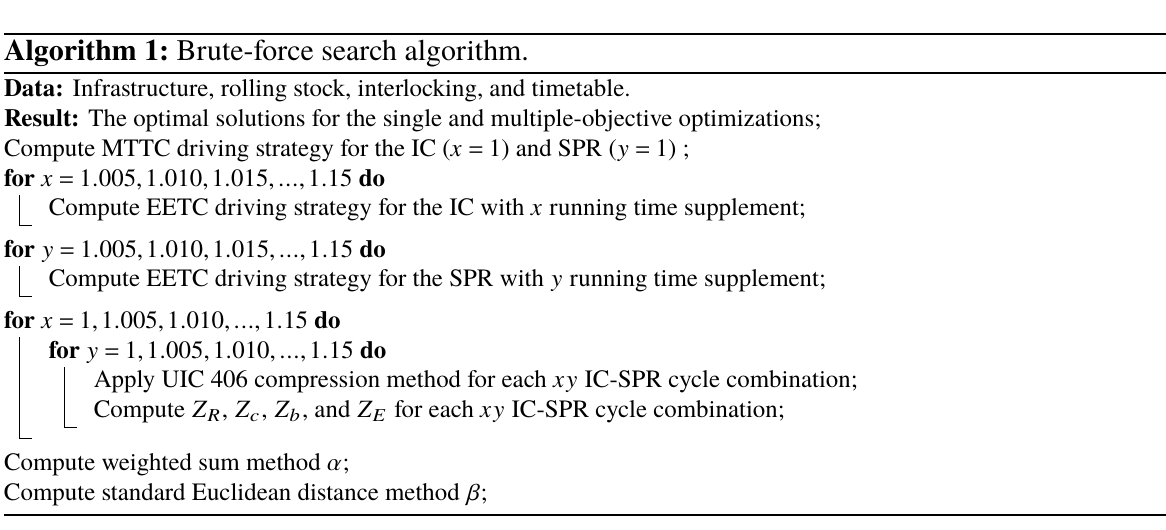
Algorithm 1: Brute-force search